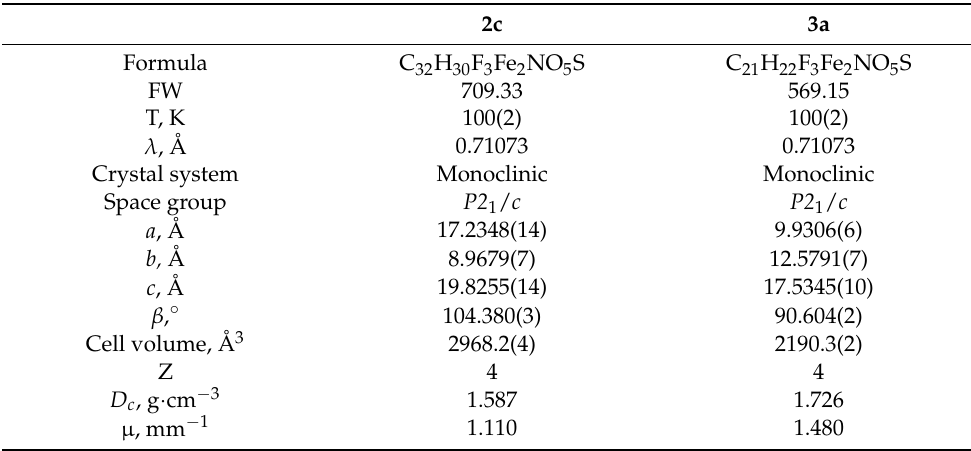
Table 1. Crystal data and measurement details for 2c and 3a